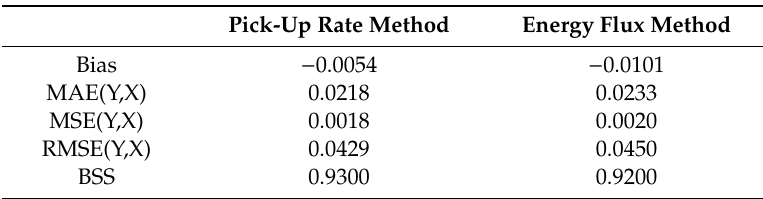
Table 3. Statistical parameters obtained in the area of interest for both the pick-up rate simulation and the energy-flux simulation-Dataset of 7